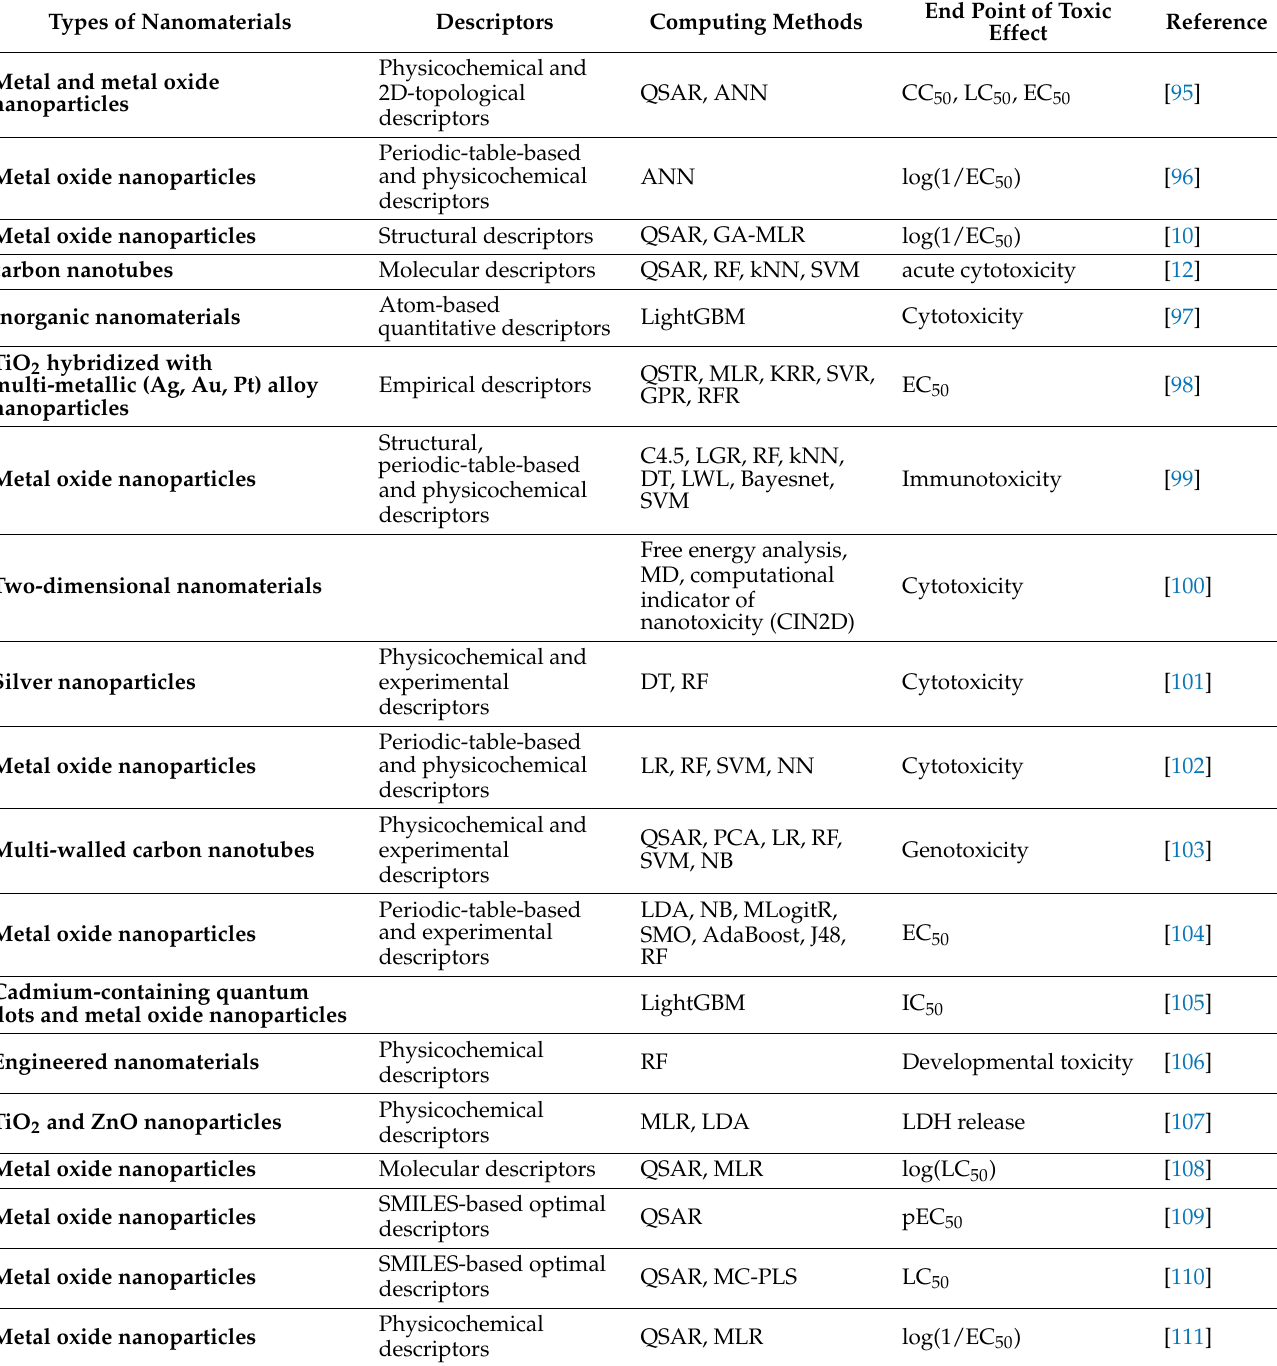
Table 1. Computational case for predicting